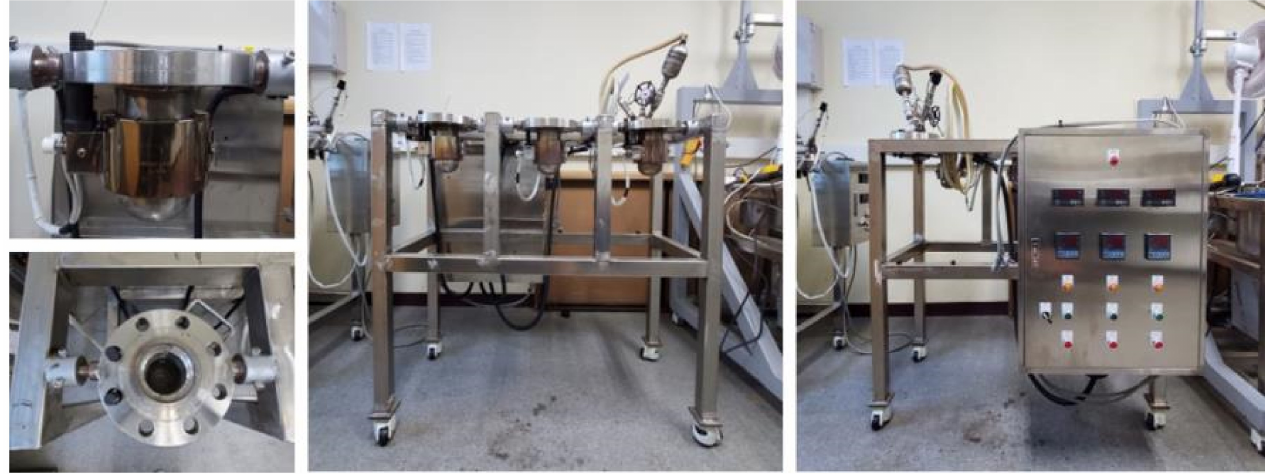
Figure 1. Laboratory-scale hydrothermal carbonization reactor (0.2